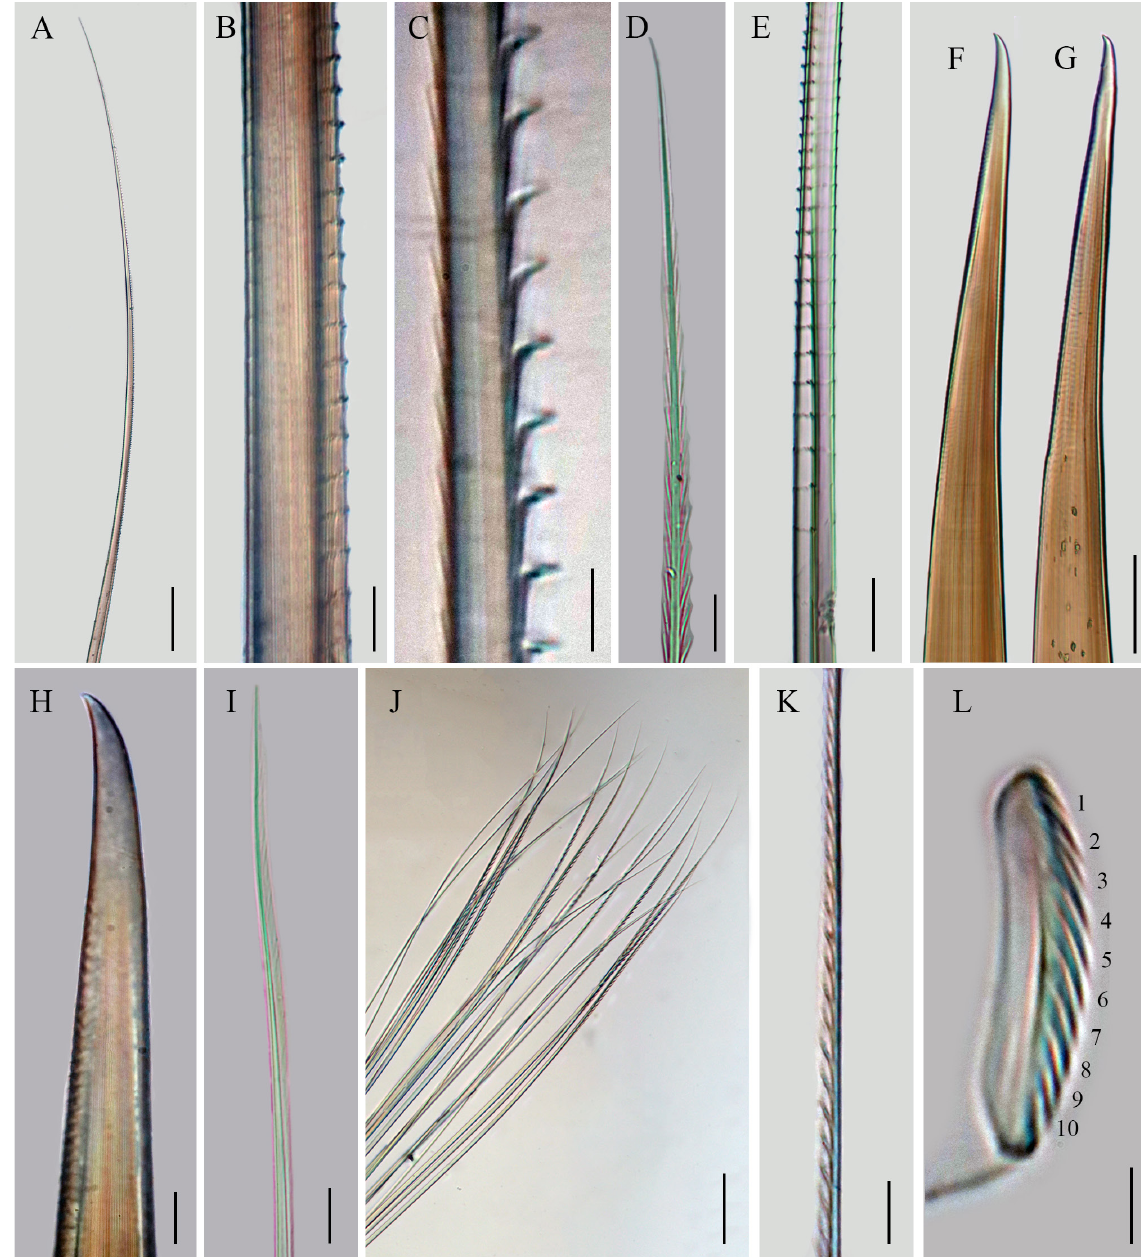
Fig. 4. Mariansabellaria caribbea sp. nov., holotype (ECOSUR-303). A . Outer palea dorsal. B . Basal region of dorsal outer palea. C . Middle region of dorsal outer palea. D . Details of the outer palea tip. E . Basal region of ventral outer palea. F . Dorsal inner palea. G . Ventral inner palea. H . Details of the inner palea tip. I . Parathoracic chaeta. J–K . Abdominal chaetae. L . Abdominal uncini. Numbers indicate the rows of teeth. Scale bars: A = 200 µm; B, D, H–I, K = 20 µm; C, L = 10 µm; E = 50 µm; F–G, J = 100